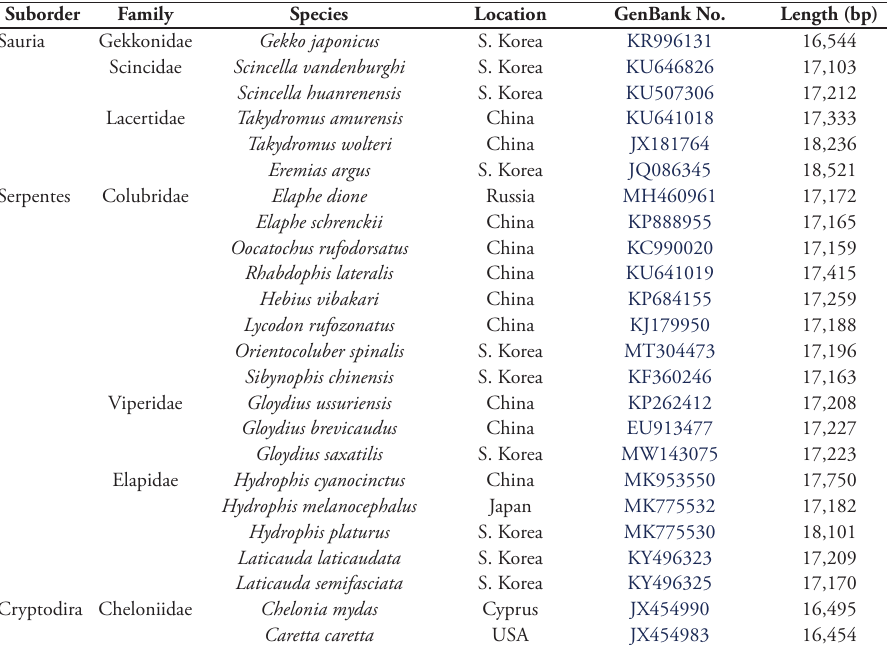
Table 1. All 22 analysed squamate species listed in South Korea and their sampling locations analysed in this study. Original sample location, GenBank accession number and mt-genome base pair length are